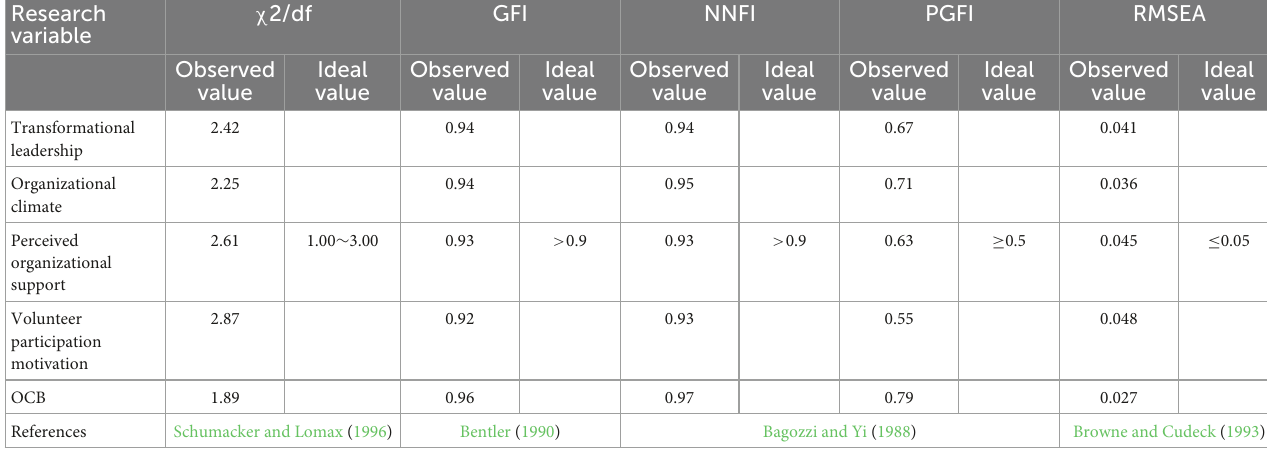
TABLE 2 Goodness of fit indicators for individual-level variables.